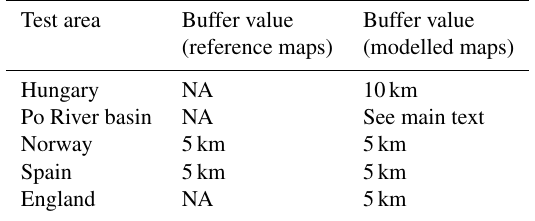
Table 2. List of parameters used to determine the extent of areas used for comparing reference and modelled maps (NA: buffer not